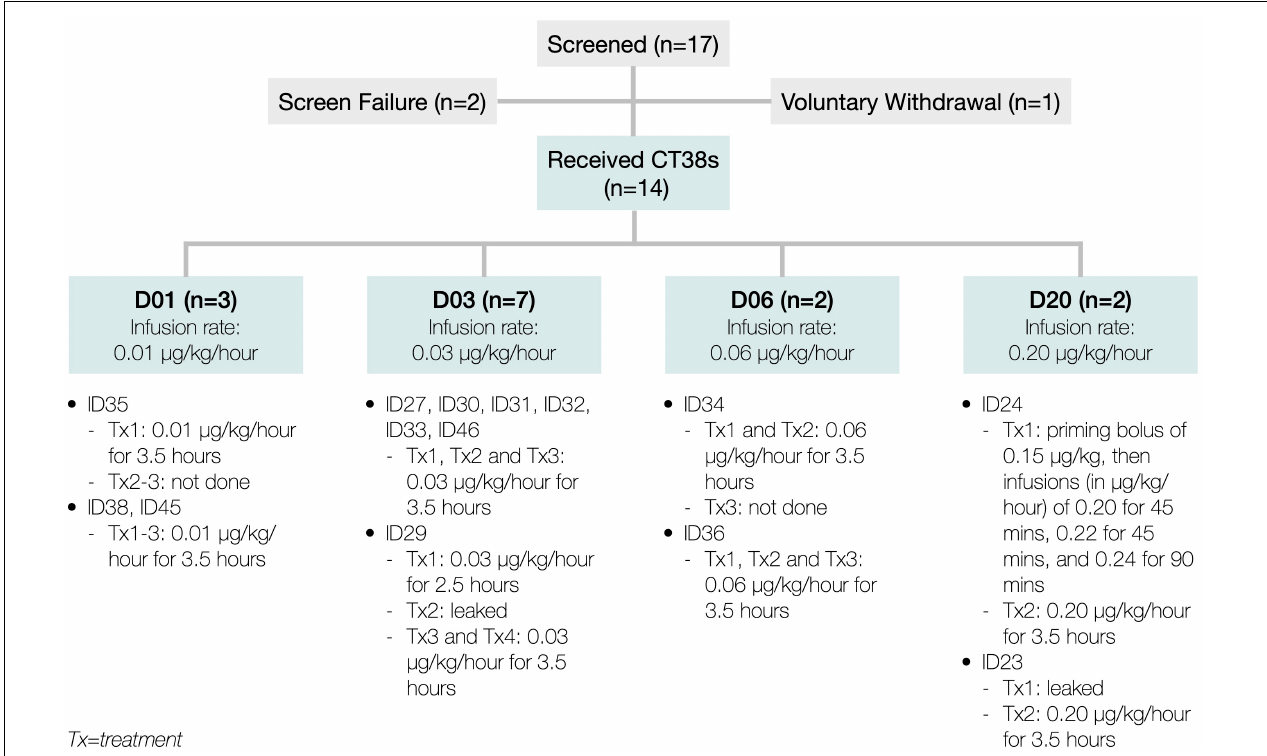
FIGURE 3 | Patient